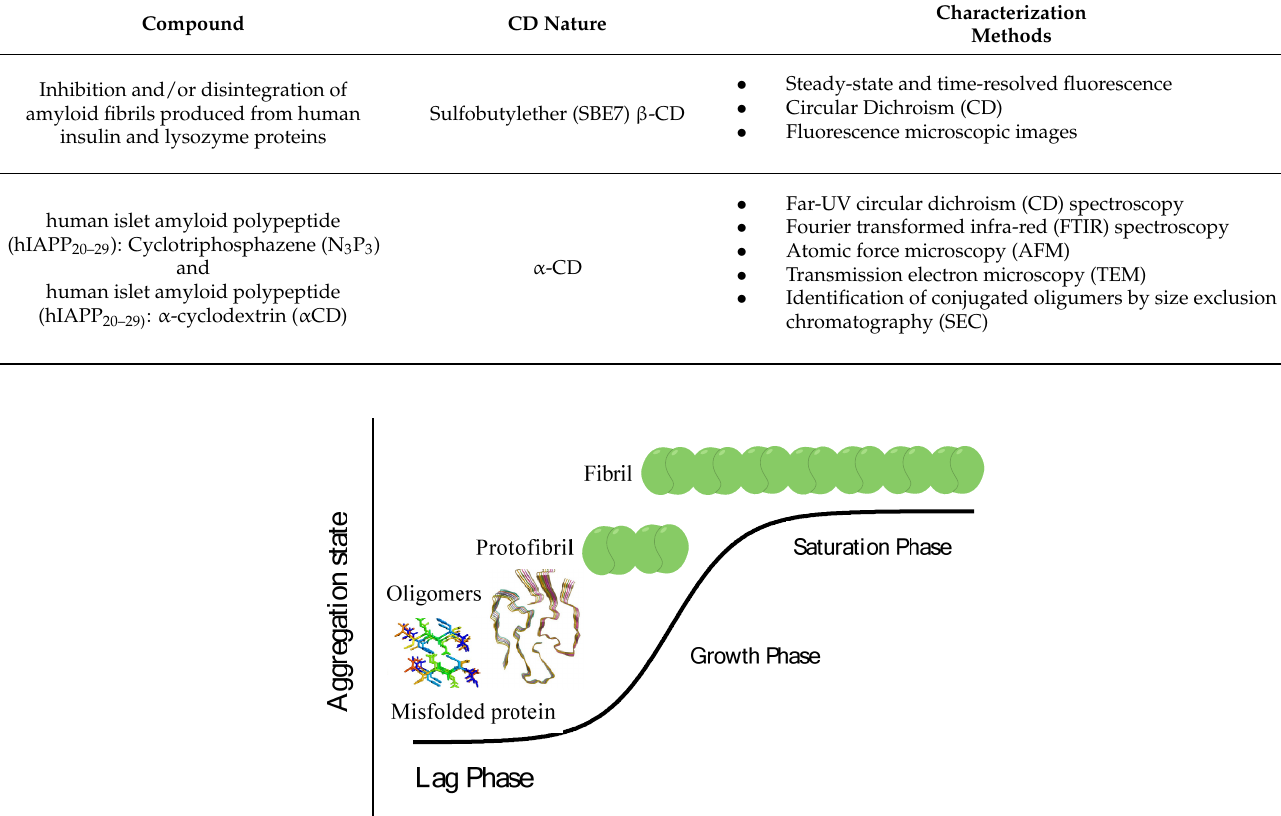
Table 2. Cyclodextrins for inhibition of A β fibrillation and chemical characterization methods. Compound CD Nature